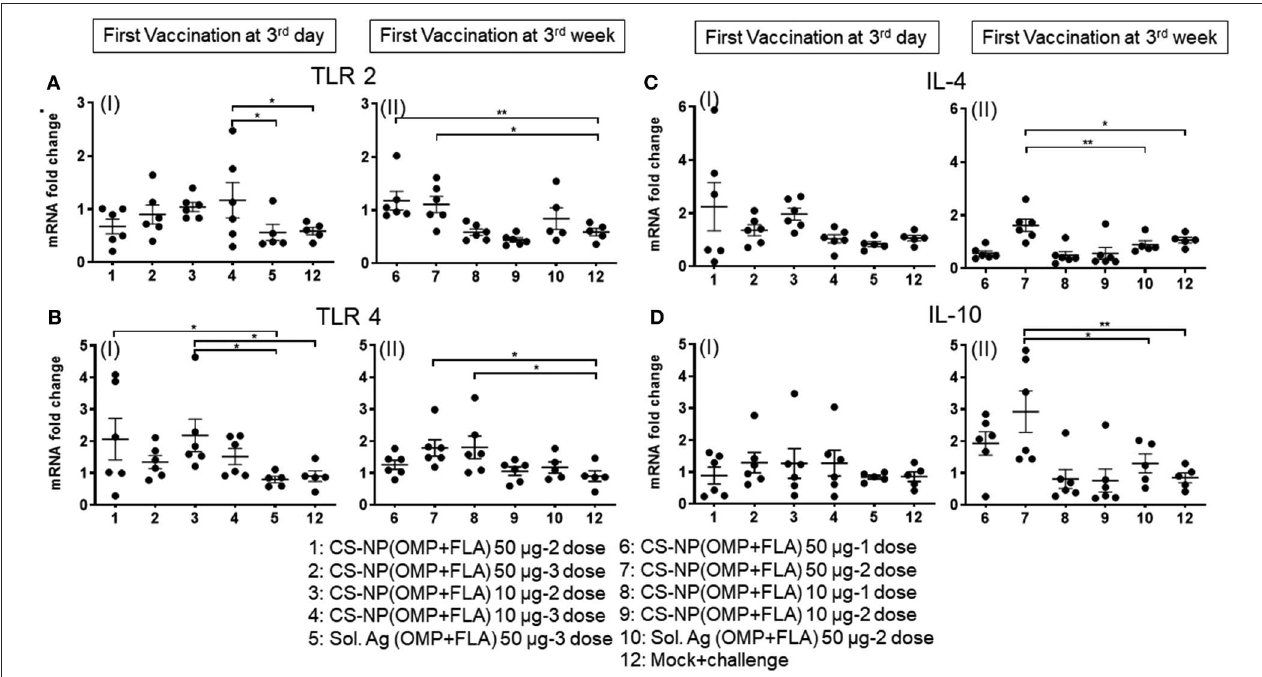
FIGURE 7 | TLR and cytokine gene expression in vaccinated and SE challenge birds. Cecal tonsils harvested on the day of necropsy were analyzed for the expression of TLRs and cytokine mRNA in CS-NP(OMP + FLA) vaccinated birds by qRT-PCR. (A) TLR 2 (I and II), (B) TLR 4 (I and II), (C) IL-4 (I and II) and (D) IL-10 (I and II). Fold-change in gene expression was calculated after correcting for β -actin mRNA value and normalizing to mRNA content of mock group. Data were presented as mean ± SEM of 6 or 5 birds. Significant difference between the indicated two groups were determined by one-way ANOVA followed by Tukey post-hoc test. * P < 0.05, ** P <